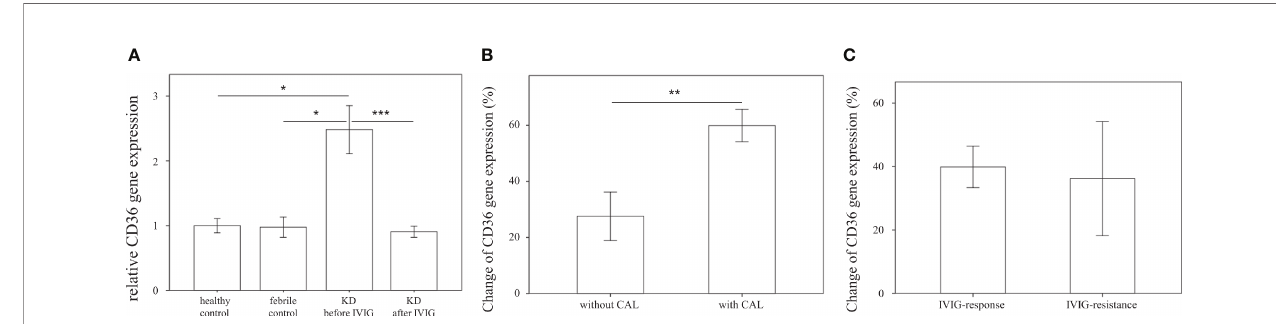
FIGURE 3 | Comparison of relative CD36 mRNA expression. (A) Relative CD36 mRNA expression levels in healthy controls (n=23, mean ± SEM 1 ± 0.11), febrile controls (n=24, mean ± SEM 0.97 ± 0.16), and in Kawasaki disease patients before IVIG (n=71, mean ± SEM 2.48 ± 0.37) and after IVIG (n=72, mean ± SEM 0.91 ± 0.09). (B) Comparison of relative CD36 percent changes before and after IVIG therapy in KD patients without CAL (n=46, mean ± SEM 0.28 ± 0.09) and with CAL (n=26, mean ± SEM 0.60 ± 0.06). Percentage changes were calculated via the following equation (KD1-KD2)/KD1 * 100%. (C) Comparison of relative CD36 percent